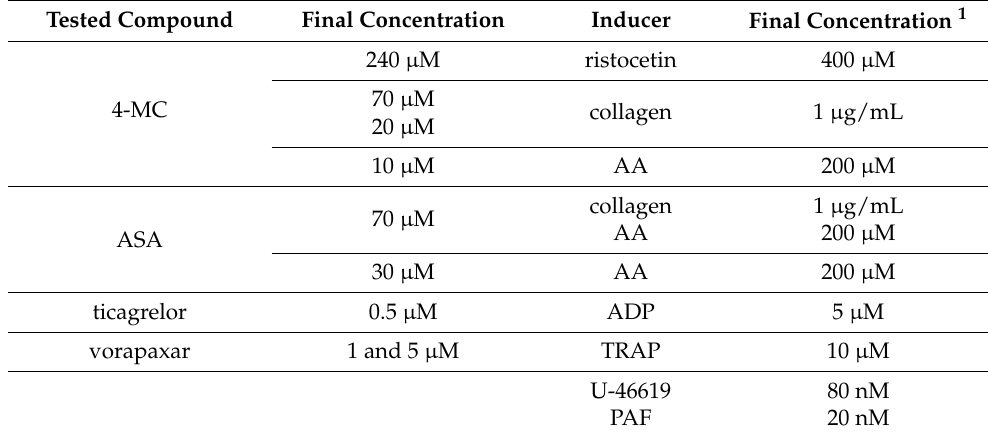
Table 1. Aggregation inducers and inhibitors in cross-sectional part of this